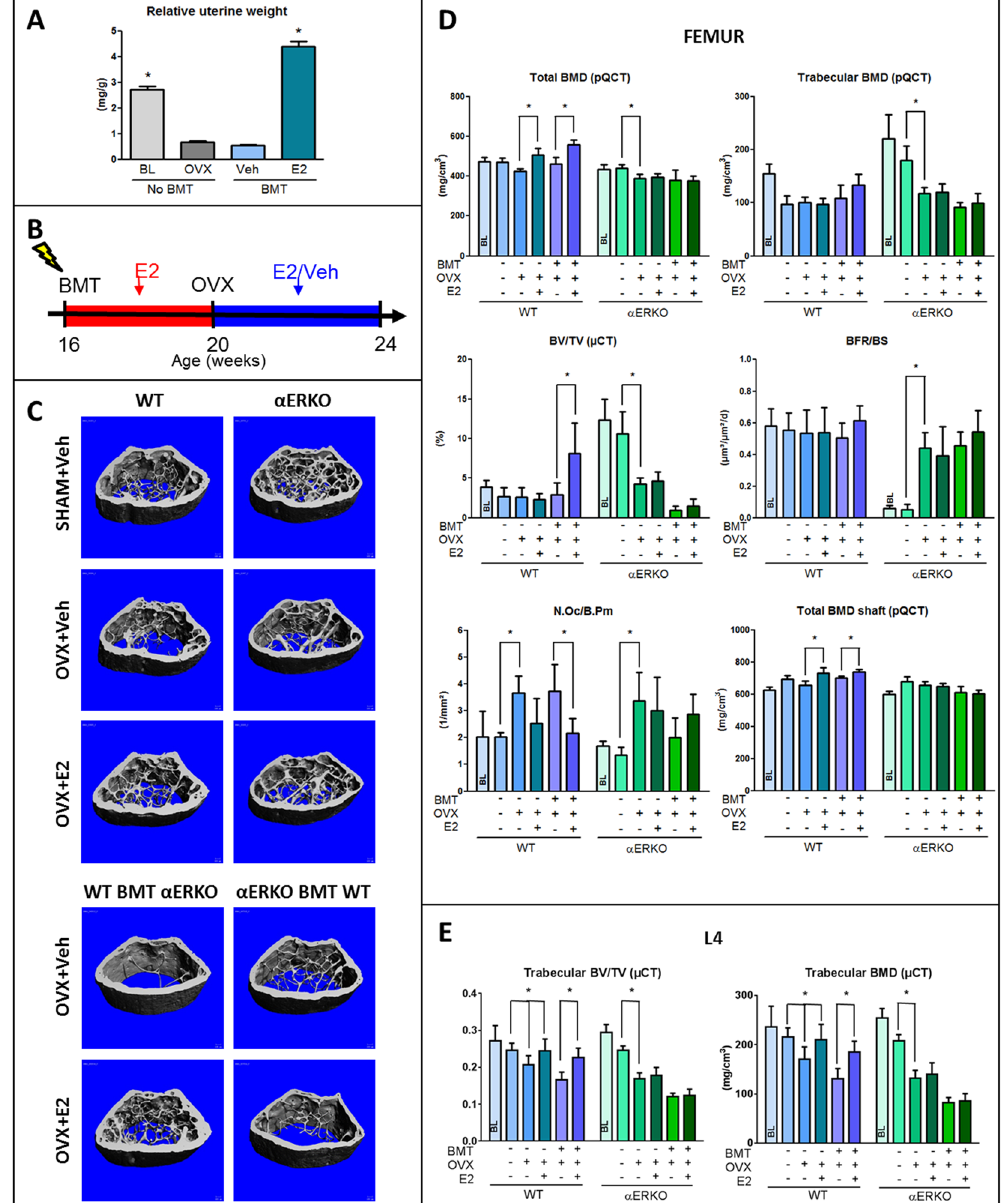
Figure 1. Selective deletion of estrogen receptor α in the mesenchymal or hematopoietic compartment. ( A ) Relative to baseline (BL) controls, uterine weight decreased in non-irradiated (No BMT) WT mice 4 weeks after OVX, similar to the decrease seen 4 weeks after irradiation (BMT) of vehicle-treated ovary-intact WT mice (Veh); 17ß-estradiol (E2) treatment of irradiated WT mice significantly increased uterine weight. ( B ) Experimental design. All irradiated mice were supplemented with physiological doses of E2 (10 µ g/kg s.c. in B/R 5 times per week) during the 4-week recovery phase post-transplantation. ( C ) µ CT images of the femoral distal metaphysis of non-irradiated (upper panels) SHAM and vehicle- or 17ß-estradiol (E2)-treated OVX WT and α ERKO mice, and vehicle- or estradiol-treated WT and α ERKO mice transplanted (BMT, lower panels) with unfractionated bone marrow cells from α ERKO or WT mice, 4 weeks post-OVX. ( D ) Total and trabecular BMD measured by pQCT and bone volume (BV/TV) measured by µ CT in the distal femoral metaphysis, bone formation rate (BFR/BS) and osteoclast number (N.Oc/B.Pm) in cancellous bone of the distal femoral metaphysis measured by histomorphometry, total BMD of the femoral shaft measured by pQCT, and ( E ) bone volume (BV/TV) as well as trabecular BMD of the L4 vertebrae in non-irradiated and reconstituted WT and α ERKO mice treated with vehicle or physiological doses of E2, 4 weeks post-OVX. All irradiated mice were supplemented with physiological doses of E2 during the 4-week recovery phase post-transplantation. Data represent mean ± SD of 8–10 animals each. * p < 0.05 by one-way ANOVA followed by SNK